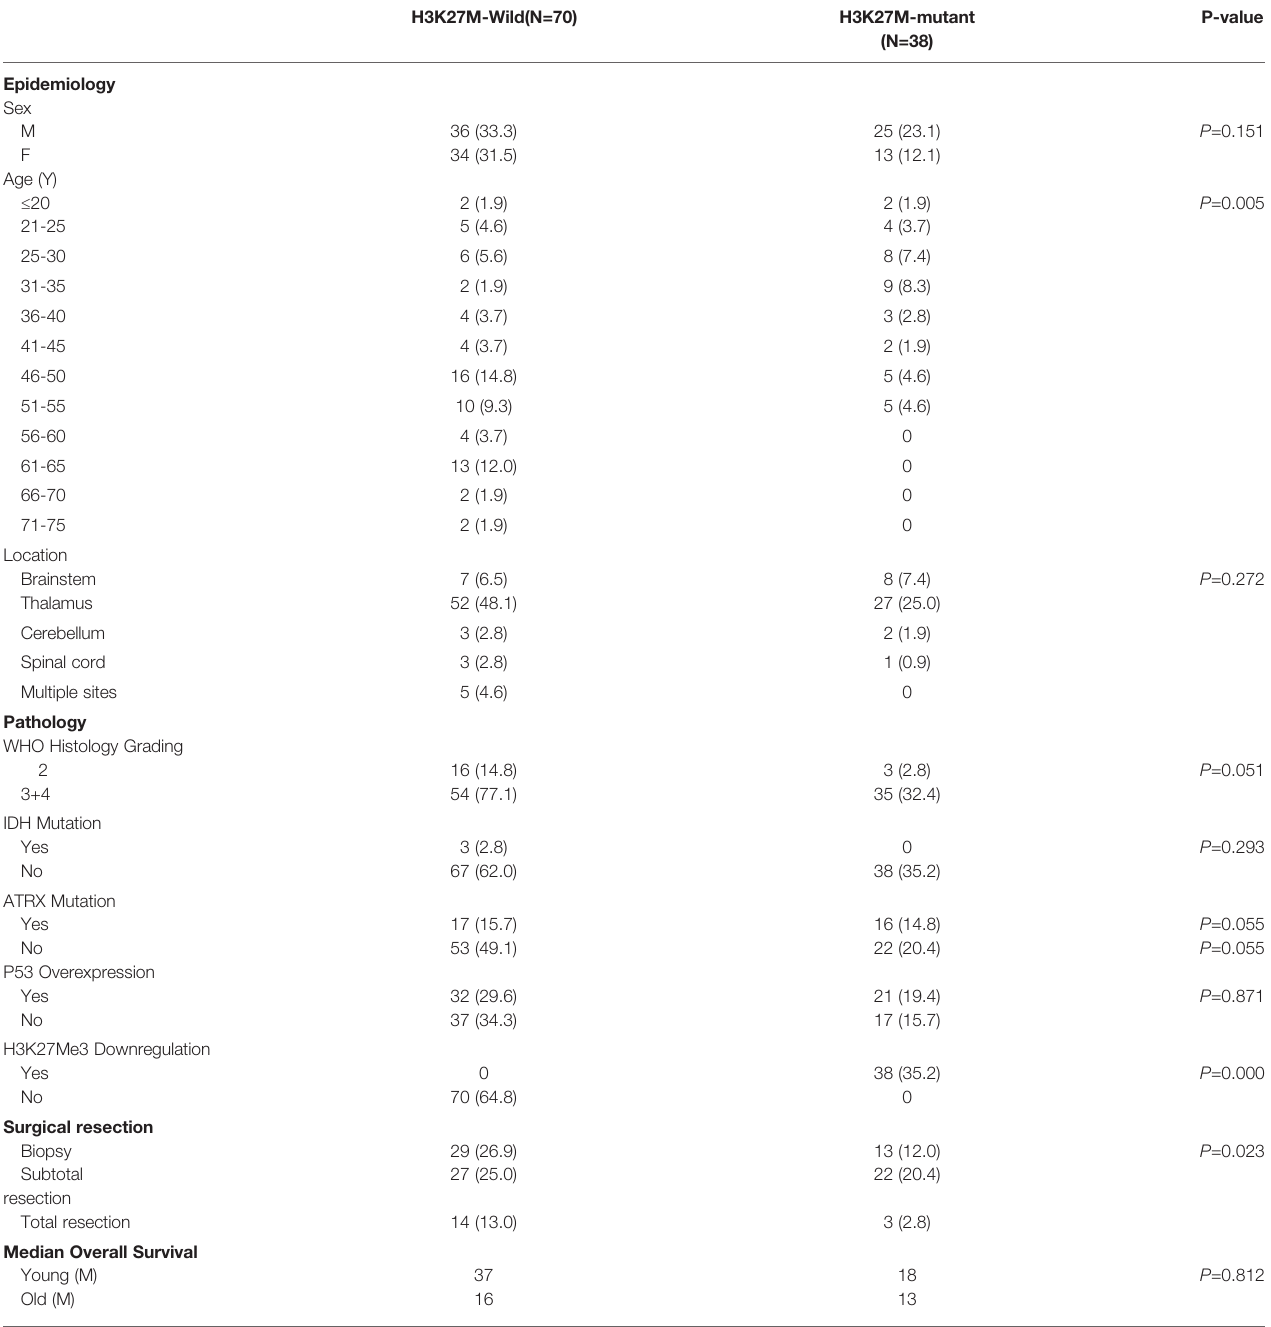
TABLE 1 | Clinical and pathological characteristics of the patients with gliomas in midline